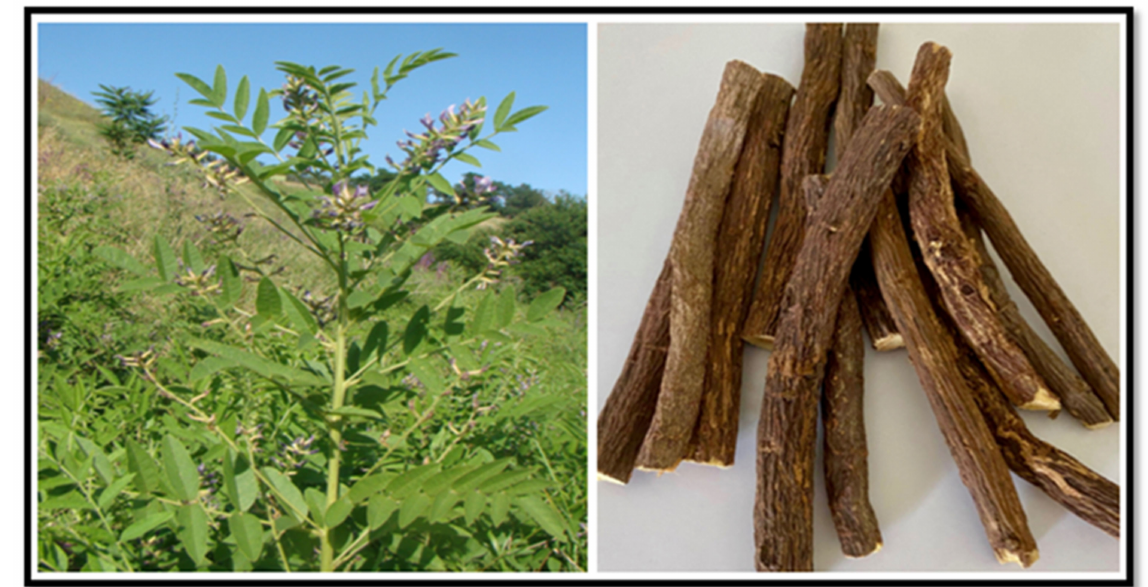
Figure 2. Licorice plant ( left ) and its root ( right